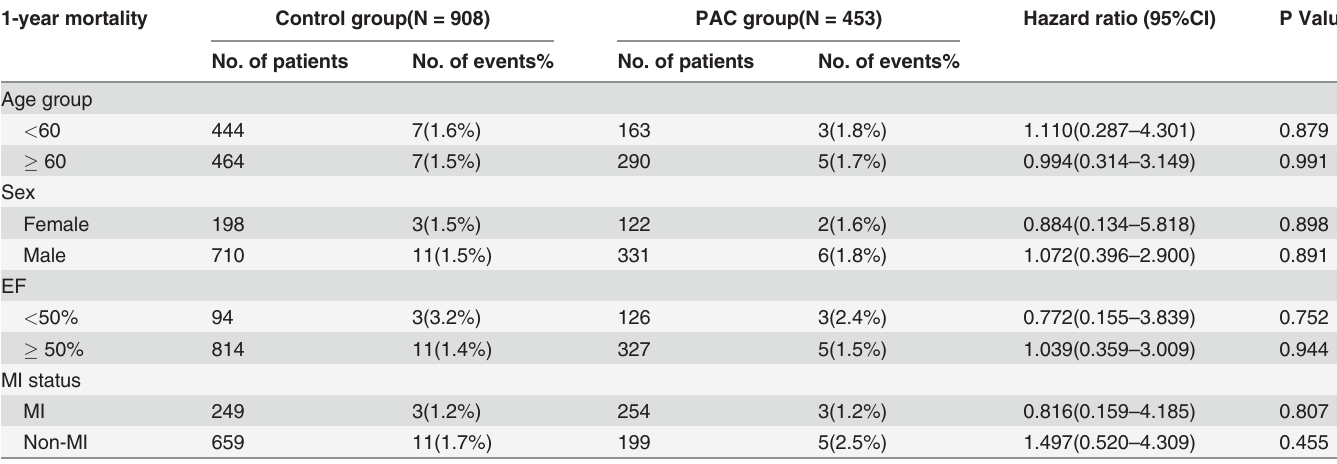
Table 5. Subgroup analysis: The impact of pulmonary artery catheter use on 1-year mortality. 1-year